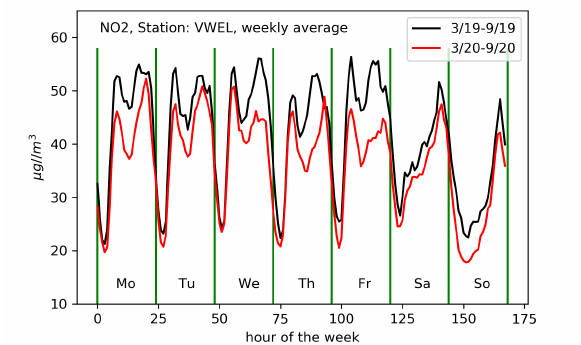
Figure 5. Comparison of the weekly average values of NO